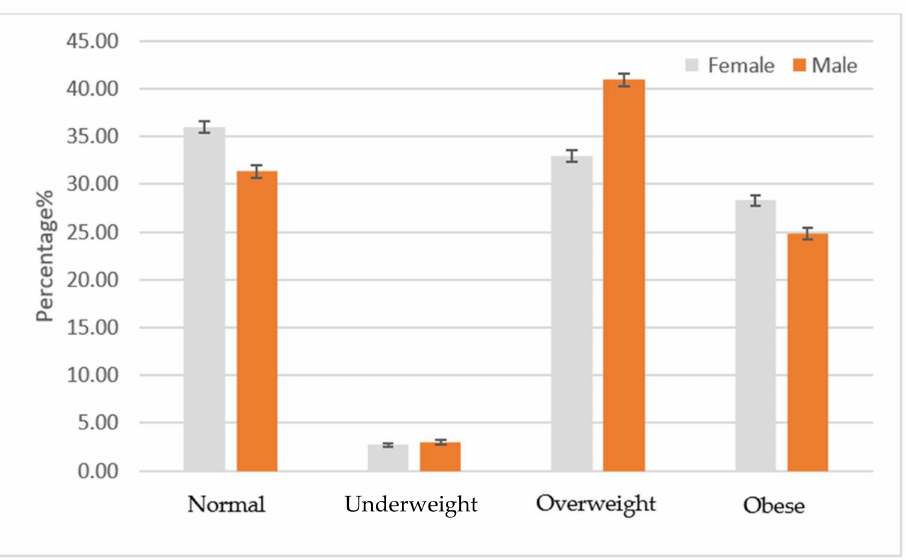
central region (western: OR = 0.74, 95% CI = 0.72, 0.75, p < 0.01 and eastern OR = 0.90, 95% CI = 0.89, 0.92, p < 0.01, Table 3).